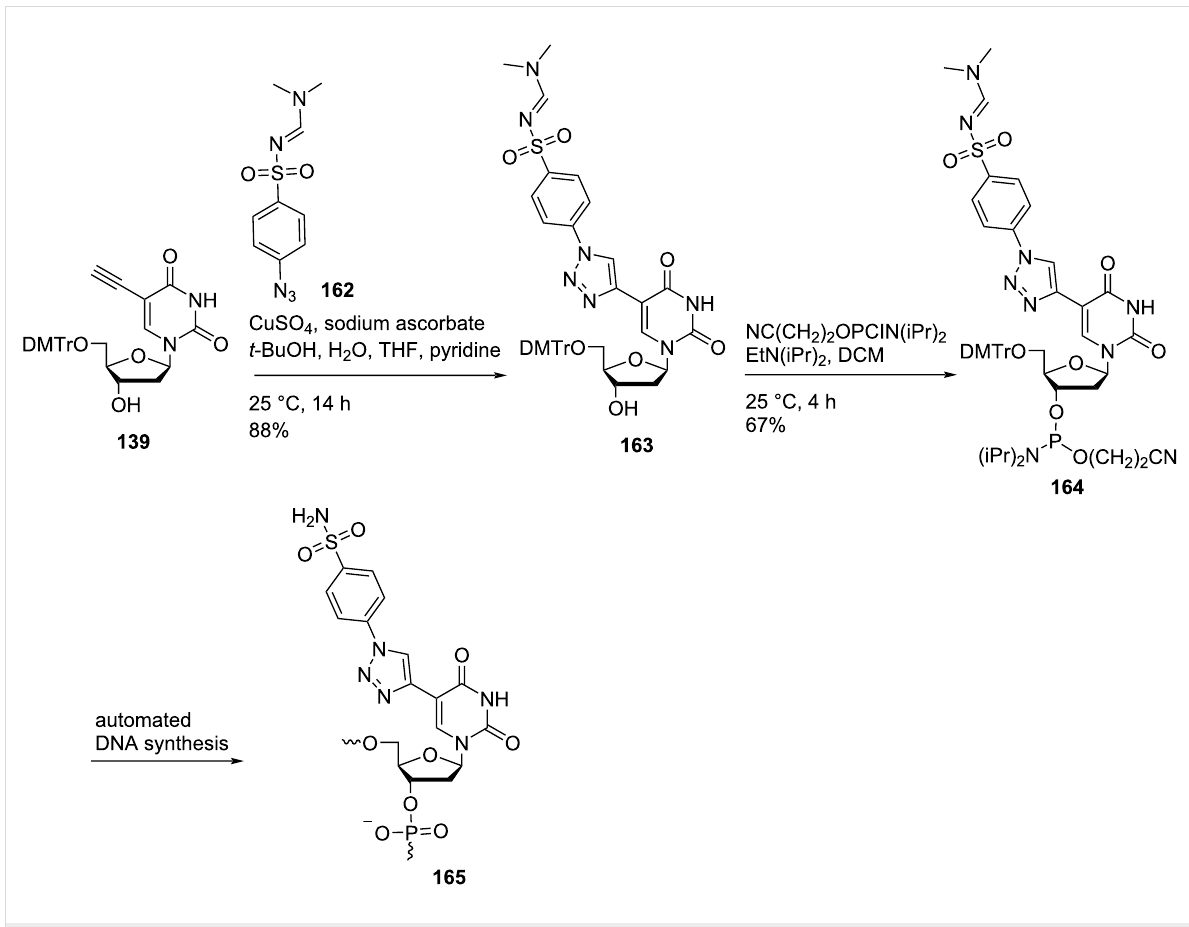
and mutant huntingtin mRNA in human patient fibroblasts.